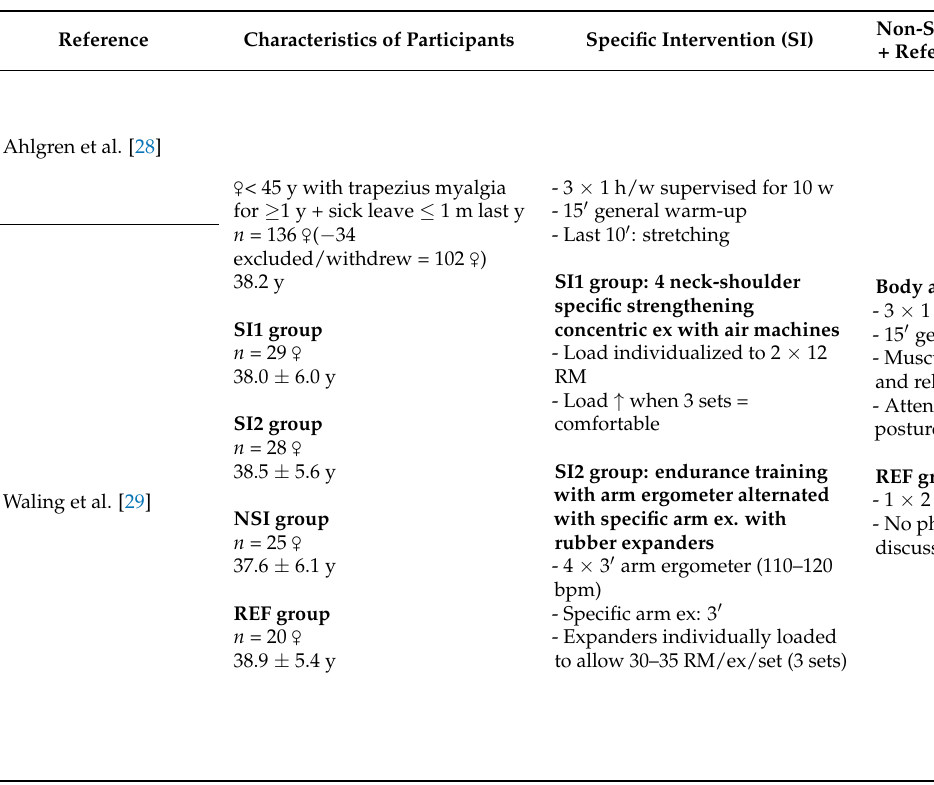
Table 4. Study characteristics. Specific strength vs. body-mind